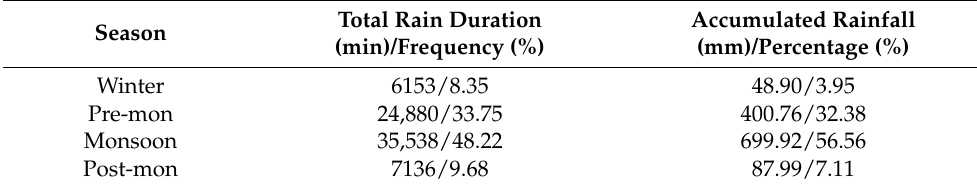
Figure 3. Accumulated raw particle counts by diameter and fall speed were observed during the four seasons: winter ( a ), premonsoon ( b ), monsoon ( c ) and postmonsoon ( d ). Solid black lines indicate the empirical fall speed–diameter relationship. Dashed lines denote the ± 60% empirical fall speed–diameter relationship. Table 1. Total rain duration and accumulated rainfall amount during the four seasons.